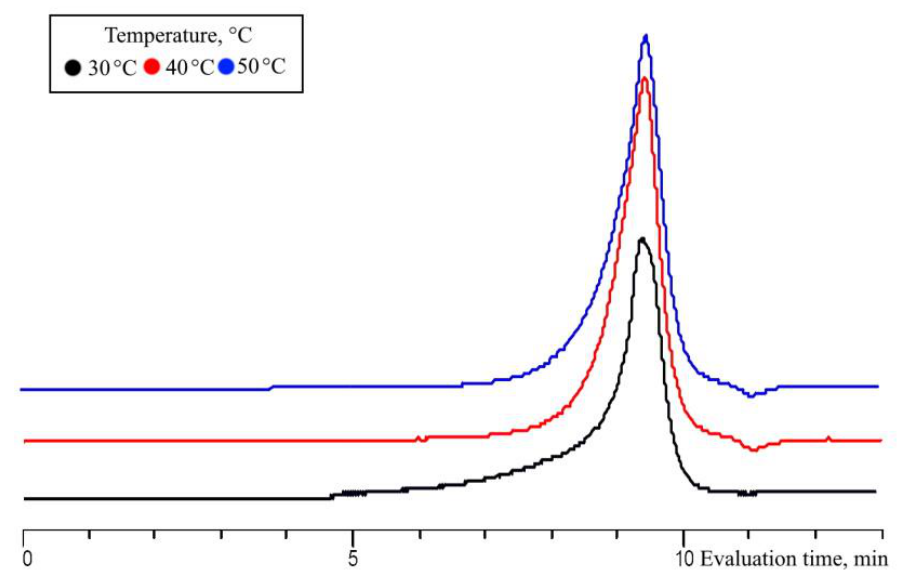
Figure 11. Diagrams of monomer and MeO-group conversions ( A ) and of the yield, MeO- and OH-